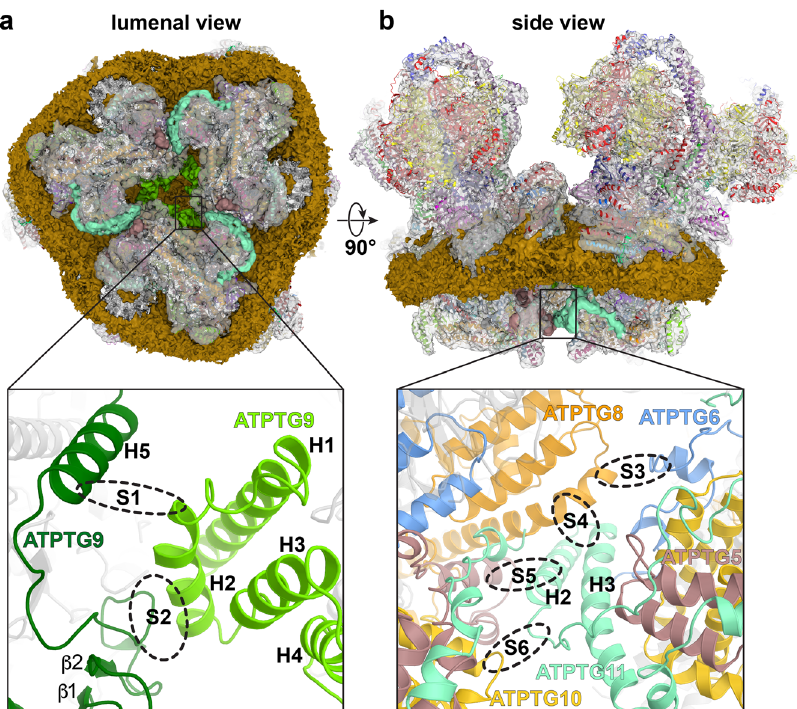
Fig. 5 Structure of T. gondii ATP synthase hexamer reveals two lumenal F o contact sites between neighbouring dimers. a First contact site is shown on the ATP synthase hexamer composite map viewed from the lumen with central lipid bilayer and surrounding detergent belt (gold). The lumenal regions of the three dimers interact to form a triangular complex (bottom panel). Three copies of the CHCHD protein ATPTG9 form homotypic interactions. b Second contact site is shown from the side view: tilted helix hairpin (H2, H3) of ATPTG11 mediates interactions with ATPTG5, ATPTG8 and ATPTG10, whereas ATPTG6 interacts with